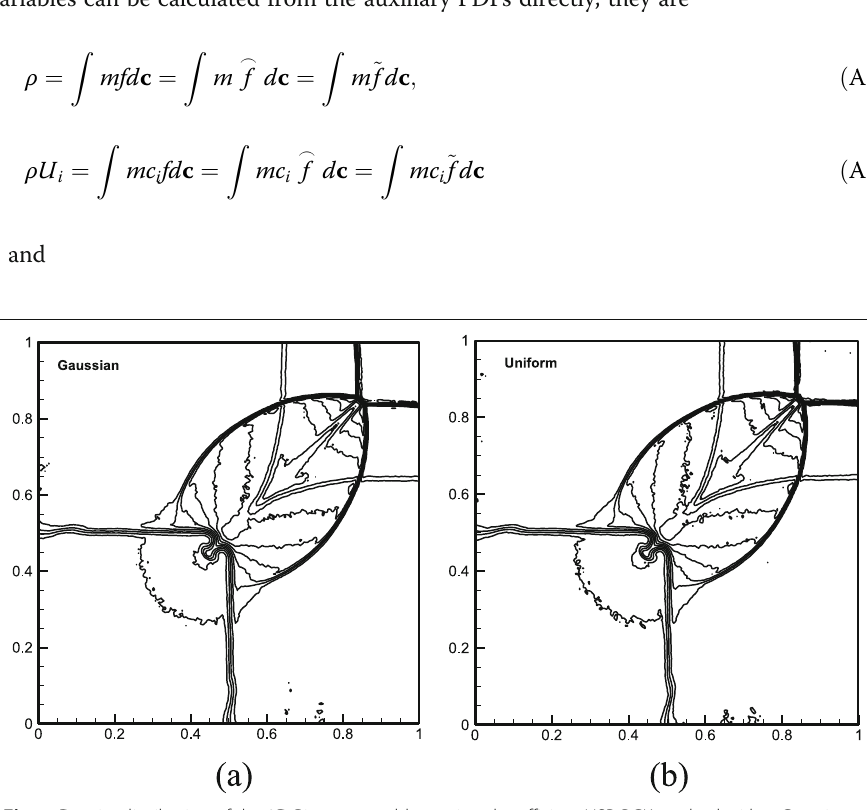
Fig. 5 Density distribution of the 2D Riemann problem using the efficient USP-BGK method with a Gaussian and b uniform kernel